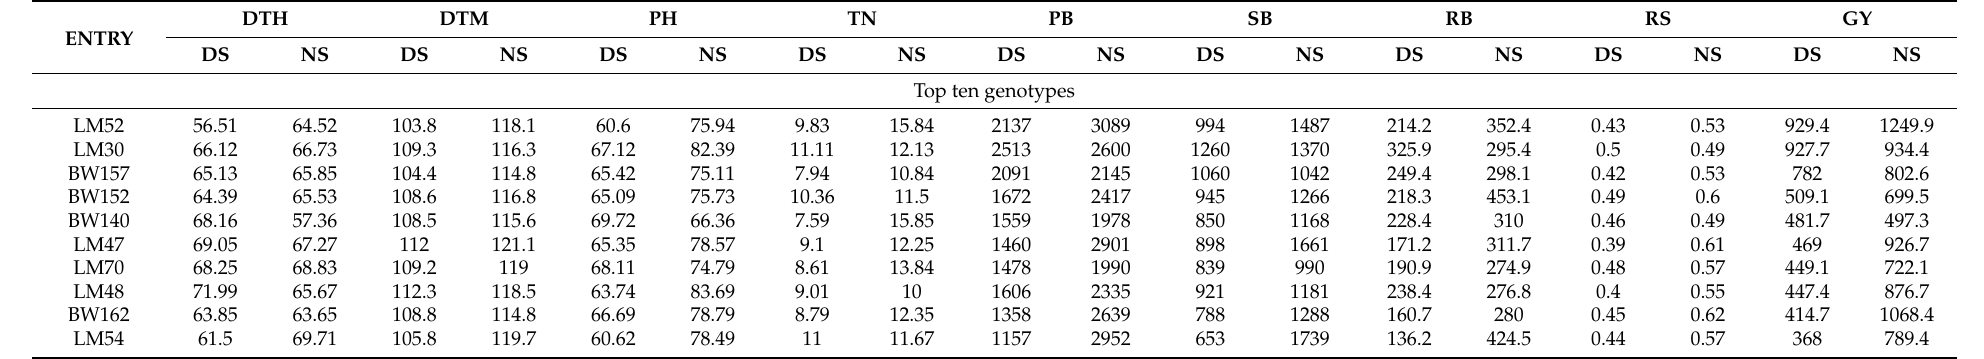
Table 3. Mean values of the 10 best genotypes and five bottom genotypes based on grain yield (GY) under drought-stress for nine agronomic traits of 97 bread wheat lines under drought-stressed (DS) and non-stressed (NS)